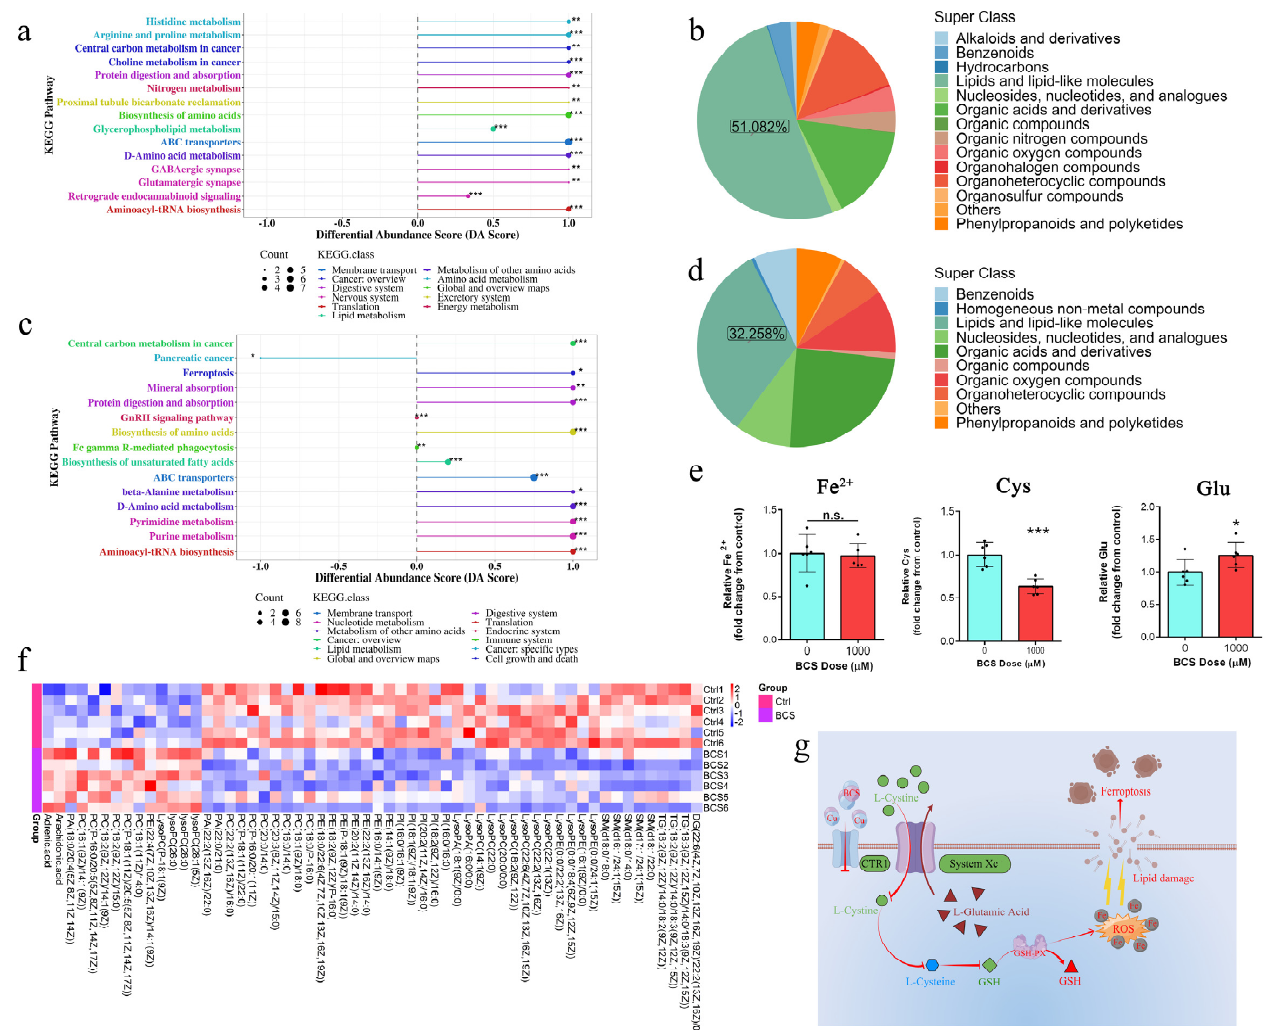
Figure 5. ( a , c ) Differential abundance score plot under the positive ion mode ( a ) and negative ion mode ( c ), respectively ( n = 6). The x-axis represents the DA-Score, and the y-axis represents the KEGG metabolic pathway. The size of each dot represents the metabolite number, the dots are distributed on the right side of the central axis, and the longer the line segment is, the more the overall expression of the pathway tends to be up-regulated. * p < 0.05; ** p < 0.01; *** p < 0.001. ( b , d ) Differential metabolites were classified using the KEGG databases under positive ion mode ( b ) and negative ion mode ( d ), respectively ( n = 6). ( e ) Measurement of Fe 2+ , cysteine, and glutamic contents in dermal papilla cells (DPCs) after 72 h of treatment with BCS (1000 µ M) ( n = 6/group). n.s. no significance; * p < 0.05; ** p < 0.01. ( f ) Clustering heat map of lipids and lipid-like molecules ( n = 6). ( g ) Model depicting that the inhibited System Xc- reduces the uptake of cystine, driving